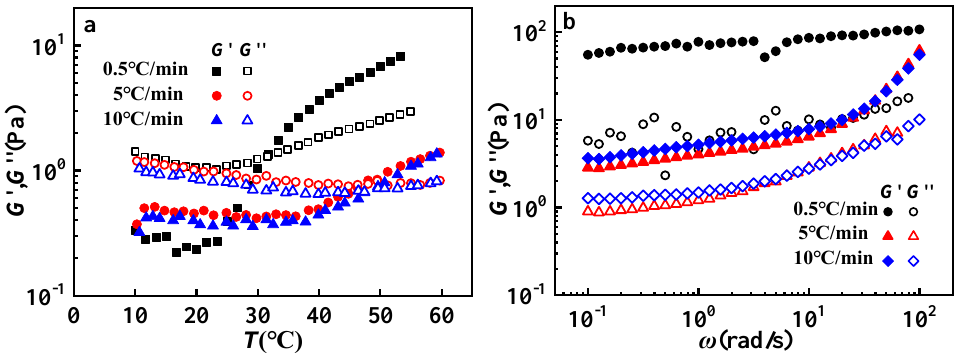
Figure 8. ( a ) Temperature sweeps of 10 mg / mL GPAM2 solutions with 0.01 M HAc during the heating process at di ff erent ramp rates; ( b ) frequency sweeps at 10 ◦ C for 10 mg / mL GPAM2 solutions with 0.01 M HAc after a thermal cycle with di ff erent ramp rates (from 10 to 60 to 10 ◦ C).